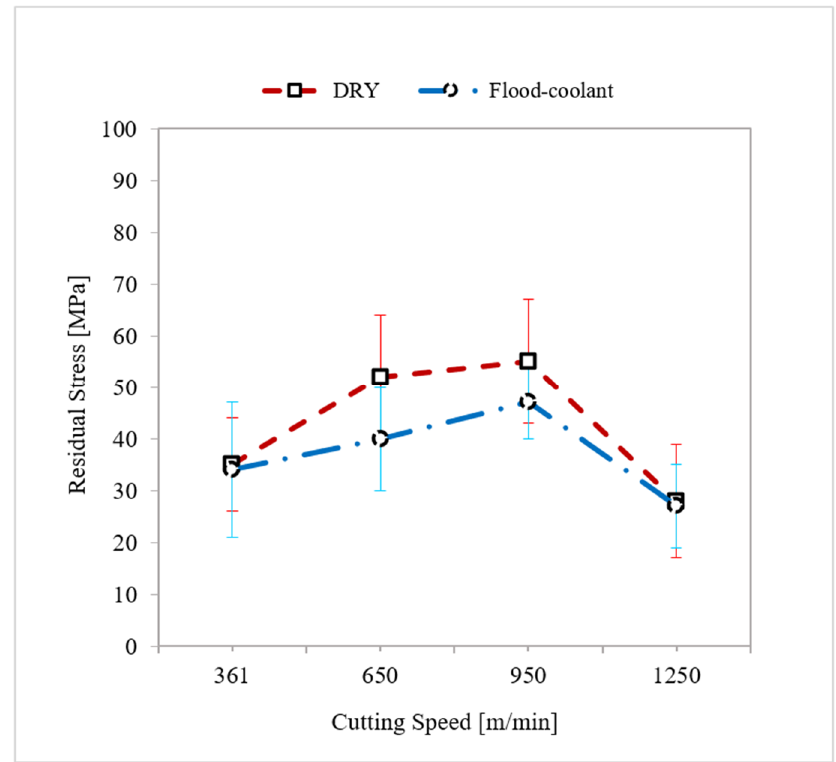
Figure 10. Variation of residual stresses with cutting speed in dry and flood-coolant modes.